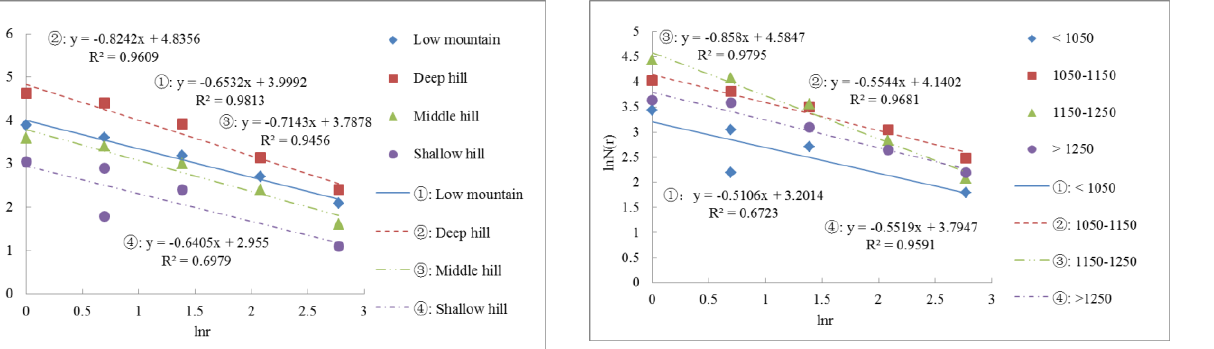
Figure 3. Fitting straight line of lnr-lnN(r) of landslide hazard points based on geomorphic types